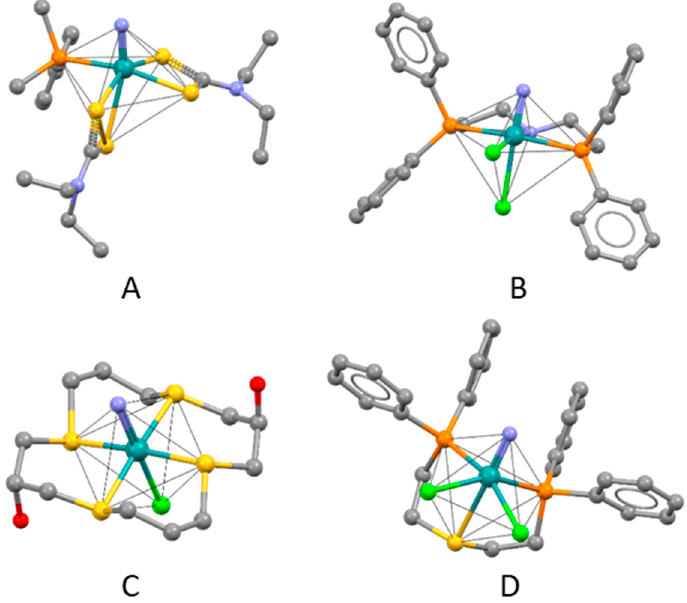
Figure 7. ( A , B ) HS: six-coordinated TcN(Et 2 dtc) 2 (PMe 2 Ph) and [TcNCl{16S4–(OH) 2 }] + ; ( C , D ) LS: six-coordinated TcNCl 2 (PNP1) and TcNCl 2 (PSP).